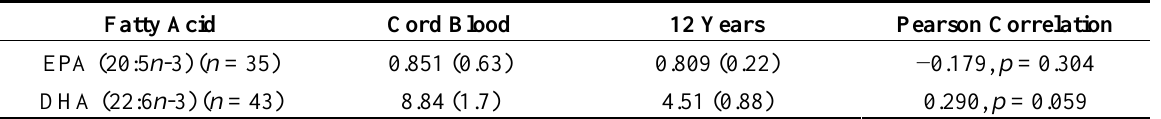
Table 2. Correlation between n -3 LCPUFA in cord blood (post supplementation) and at 12 years ( n = 35).